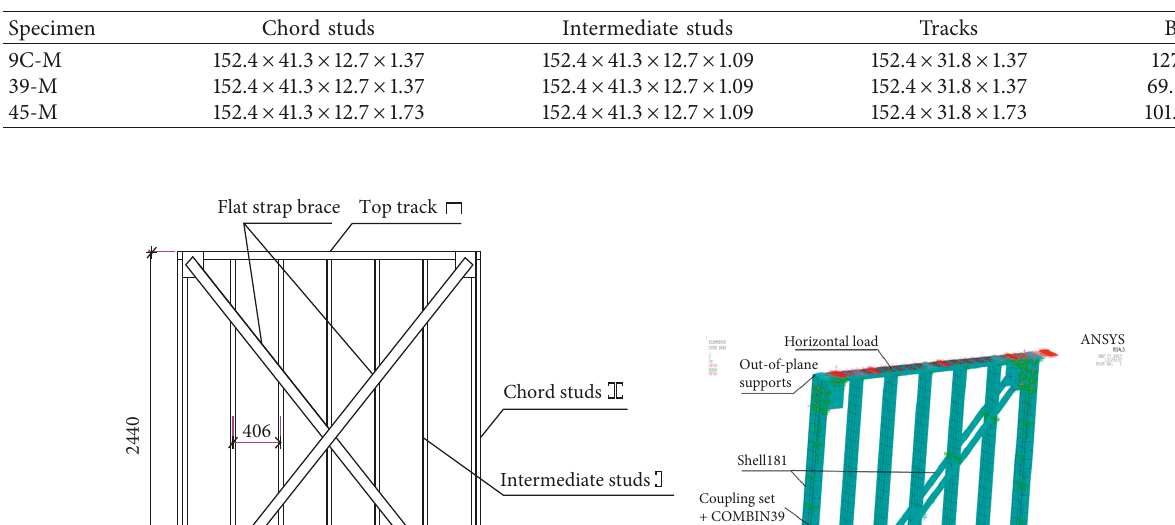
Table 1: Al-Kharat’s CFS walls elements